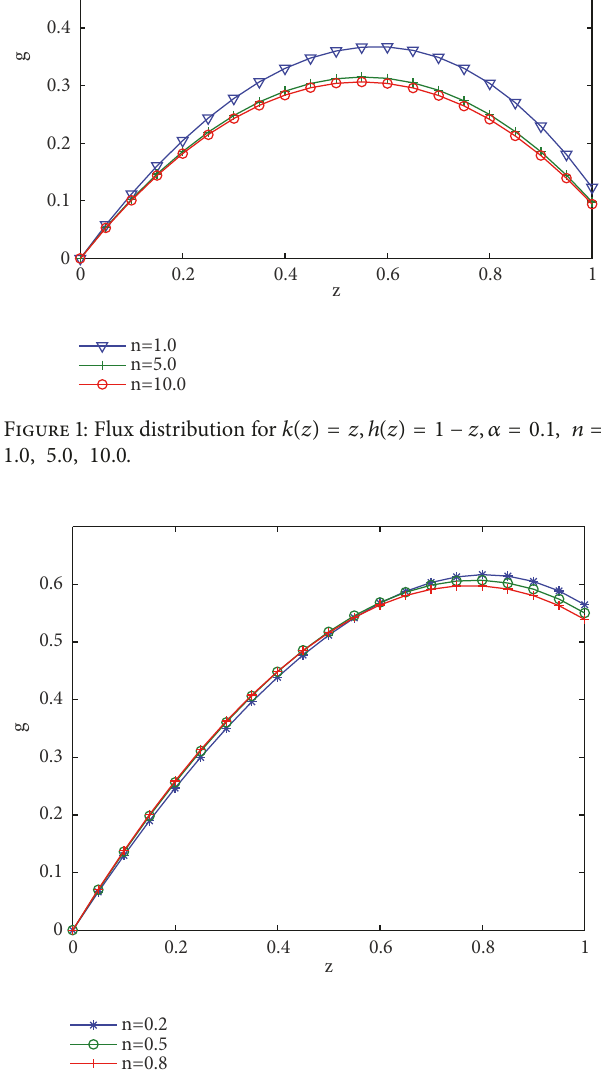
easily obtain the graph of the diffusion flux distribution for 𝑘(𝑧) = 𝑧 , ℎ(𝑧) = 1 − 𝑧 , and different values of 𝛼 and 𝑛 . The results are given in Figures